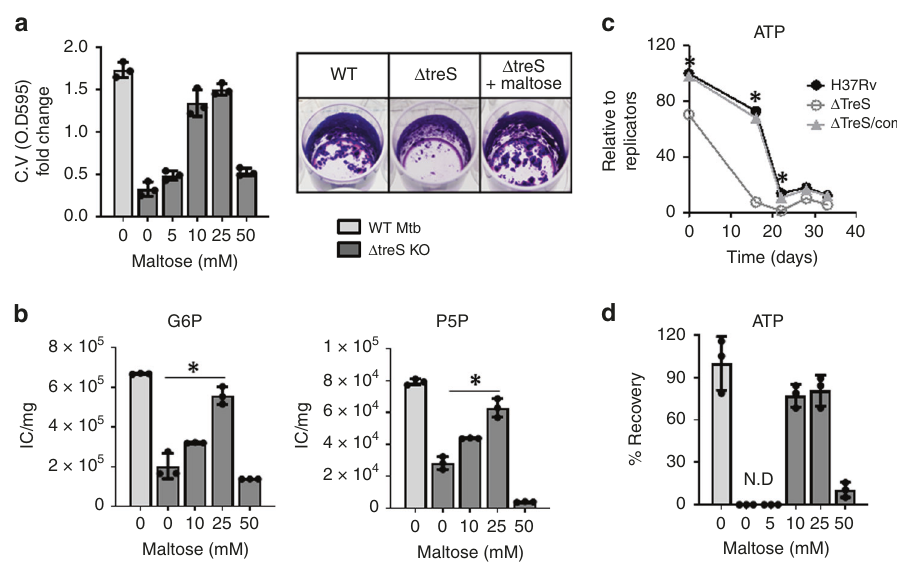
Fig. 3 Maltose-chemical rescue of Δ treS PLB formation. a CV staining OD 595 values of 28-day-old Δ treS PLB fraction generated within mycobacterial bio fi lm culture in the presence of 0 – 50 mM maltose (left panel), and CV staining patterns of WT Mtb, Δ treS, and Δ treS treated with 20 mM maltose (right panel). b The effects of supplementing various concentrations of maltose on the Δ treS PLB metabolome. Total bar heights indicate intrabacterial pool sizes compared with Δ treS with no maltose supplement or WT Mtb. c Time course of intrabacterial ATP levels of WT Mtb (H 37 Rv), Δ treS, and Δ treS/com while incubating within mycobacterial bio fi lm culture. d The effect of supplementing Δ treS PLB fraction with 20 mM maltose on intrabacterial ATP levels at day 28. All values are the average of biological triplicates ± s.e.m. * P < 0.001 by Student ’ s unpaired t -test. G6P, glucose 6-phosphates; P5P, pentose 5- phosphates. Source data are provided as a Source Data fi le